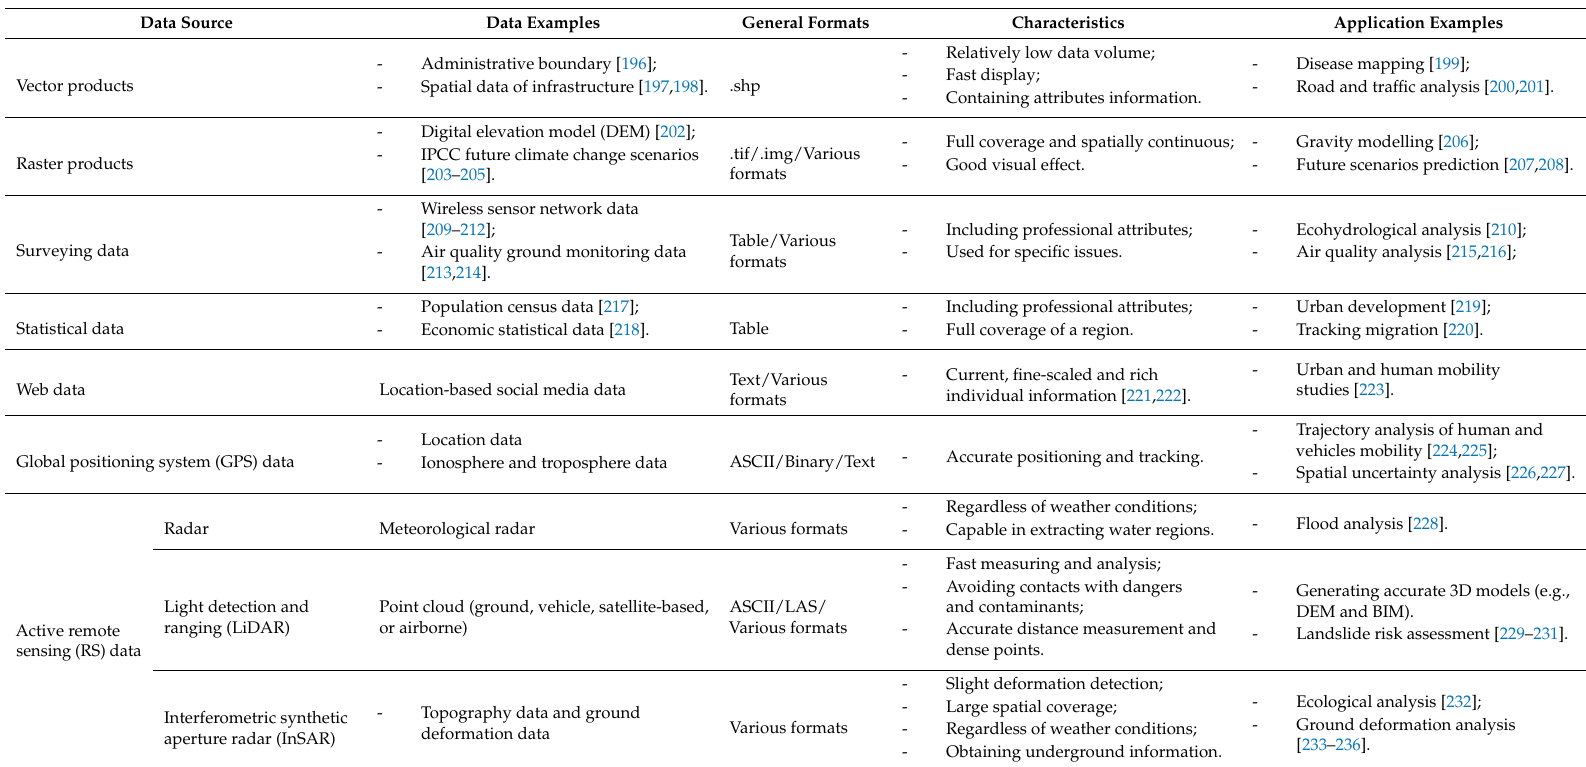
Table 7. Comparison of GIS data